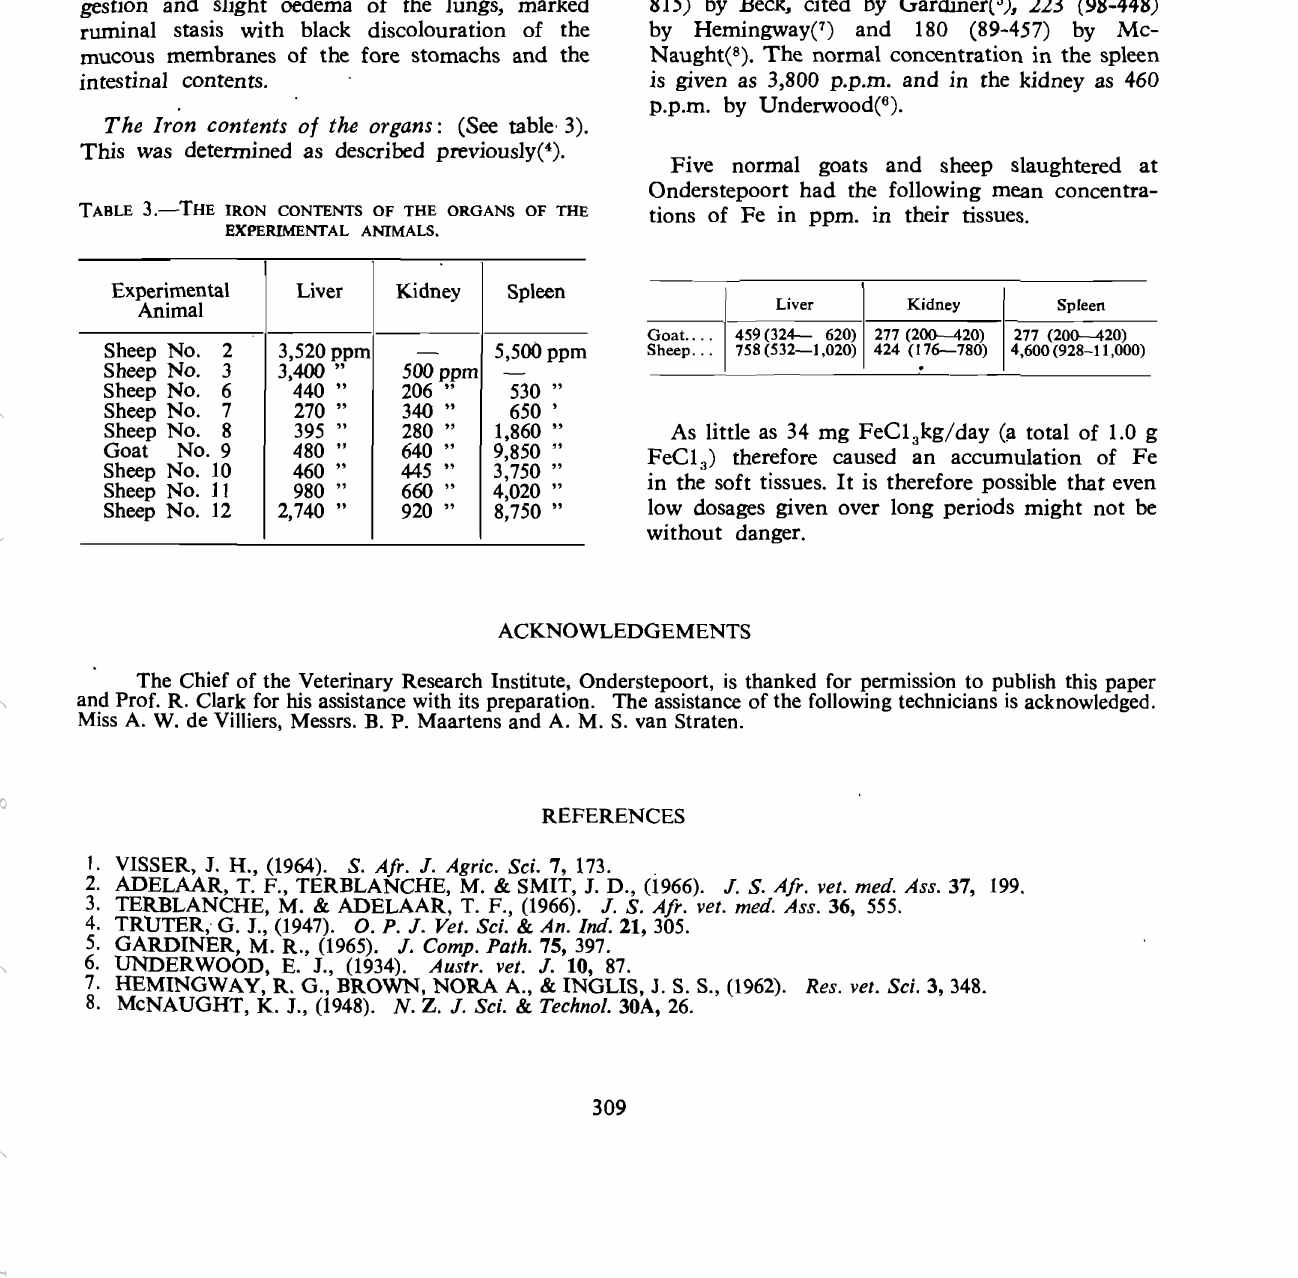
TABLE 3.-THE IRON CONTENTS OF THE ORGANS OF THE EXPERIMENTAL ANIMALS.